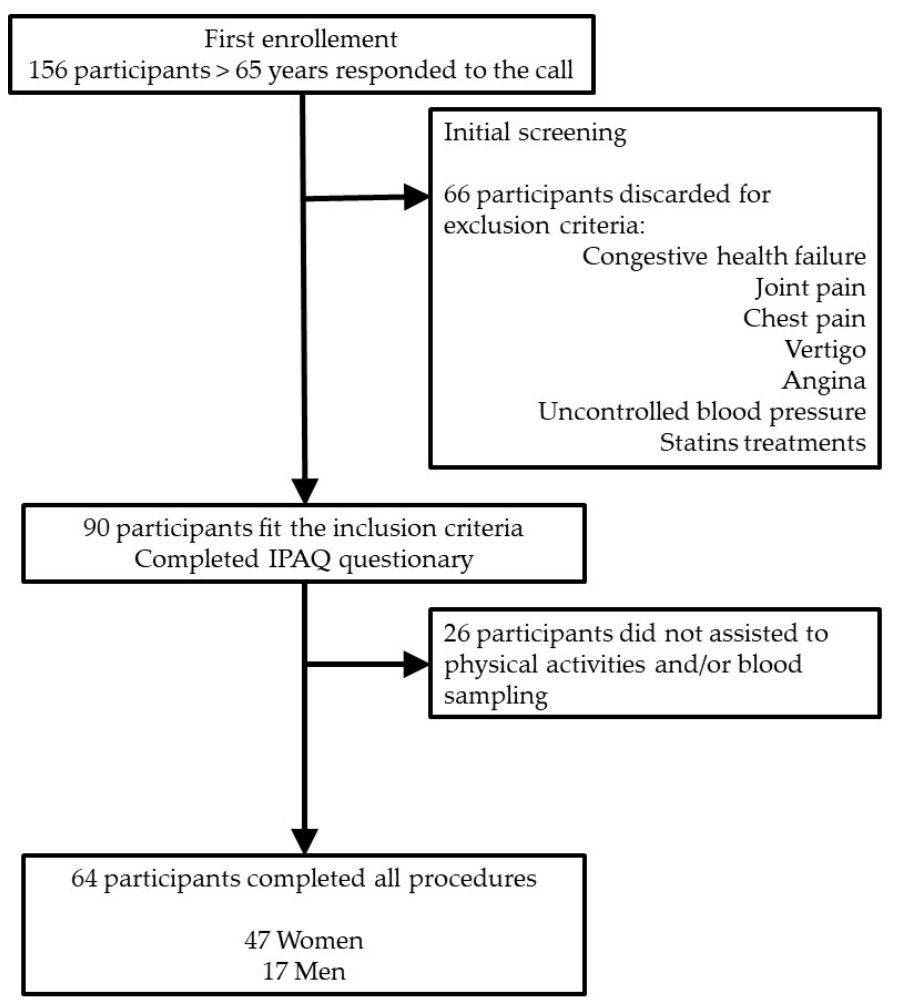
Figure 1. Flow chart of the study selection. Table 1. Age, social and clinical characteristics of the participants in the